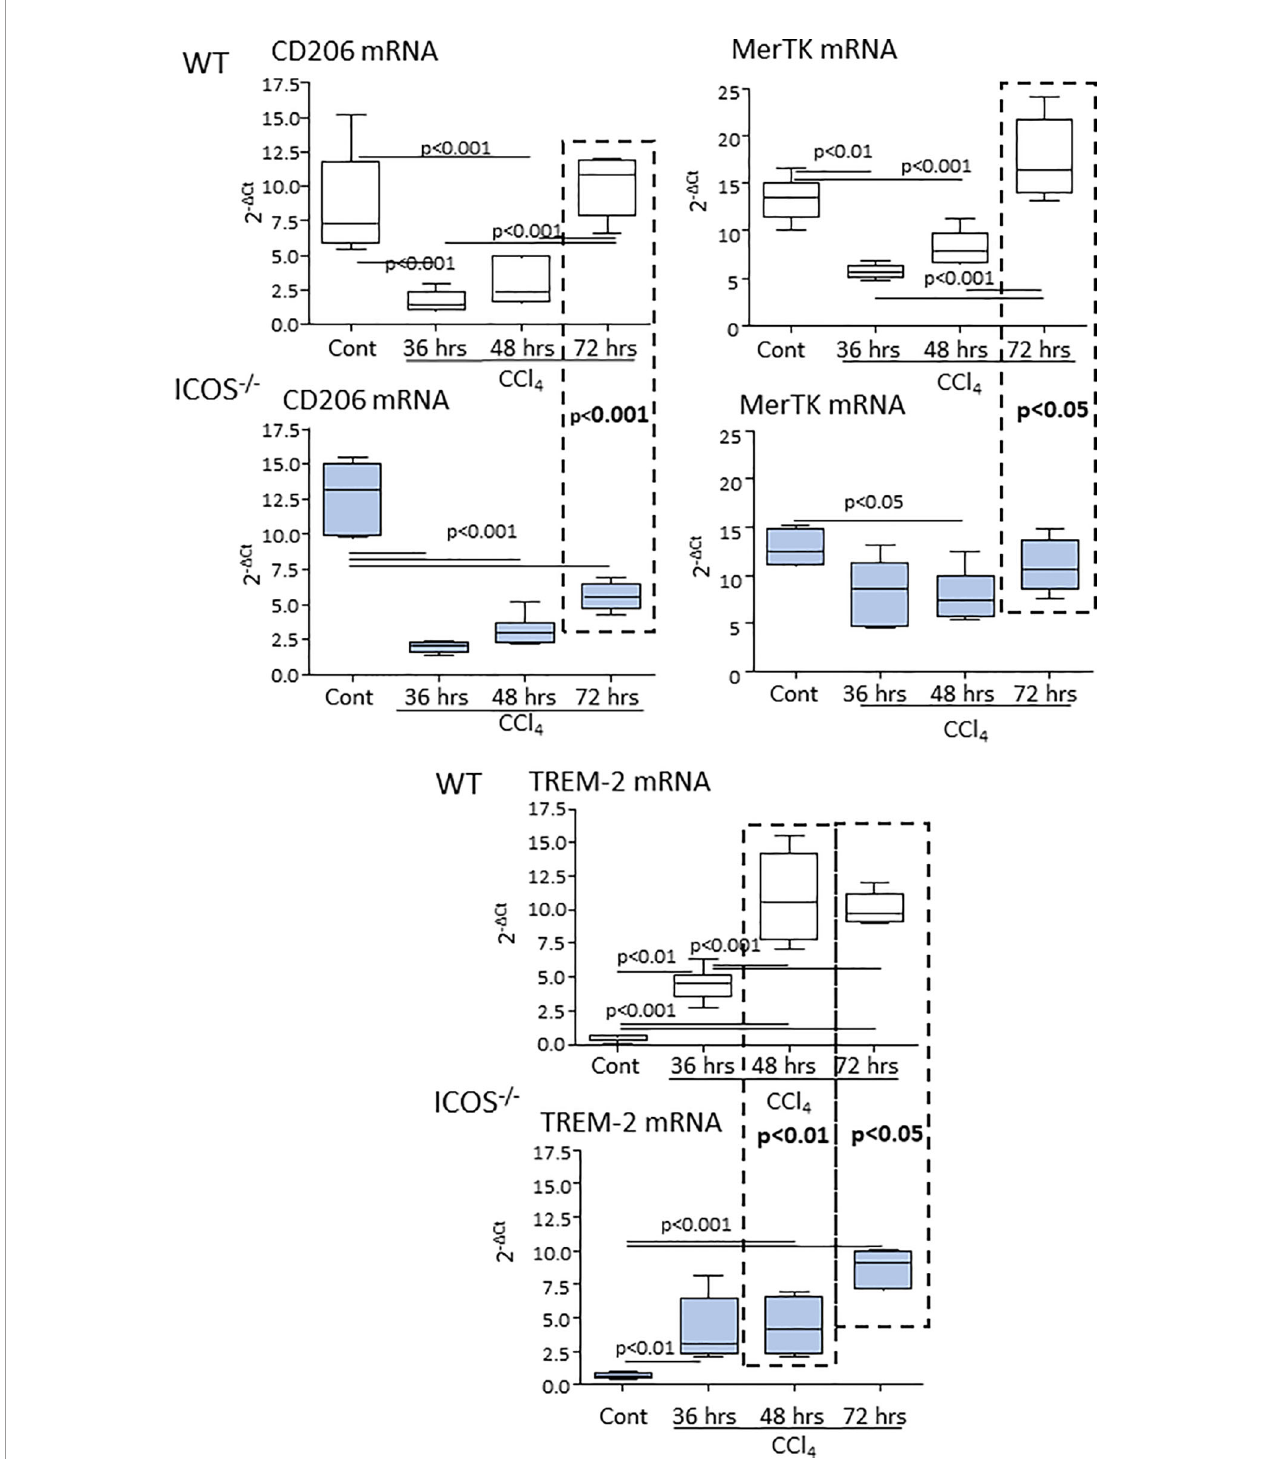
FIGURE 4 | ICOS de fi ciency impairs the expression of reparative MoMF markers during the evolution of acute liver injury. The transcripts of reparative MoMF markers CD206, MerTK, and TREM-2 were evaluated by Real-Time PCR in the liver of wild-type and ICOS -/- mice at different time points following the administration of CCl 4 . The vertical dotted boxes indicate statistically signi fi cant differences between wild-type and ICOS -/- mice at each time point. The results are expressed as mean ± SD of 5-8 animals for each time